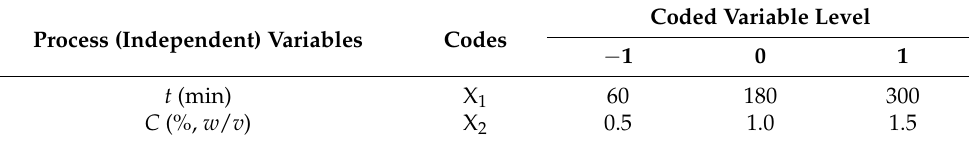
Table 1. The levels (actual and coded) of the process variables used to set up the experimental design. Process (Independent)